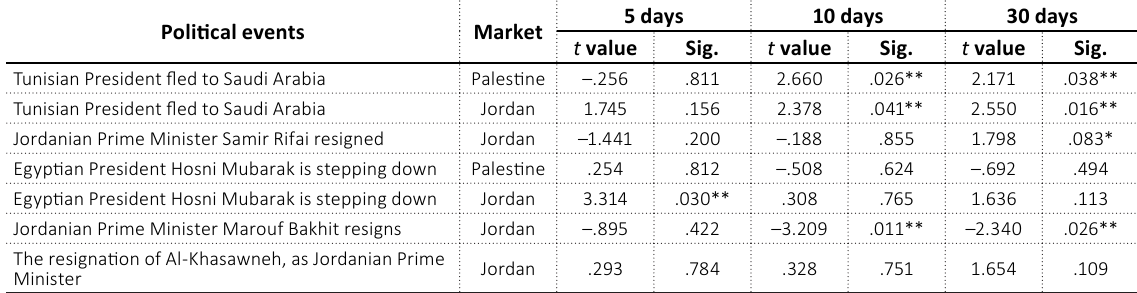
Table 8. Paired t -test for political